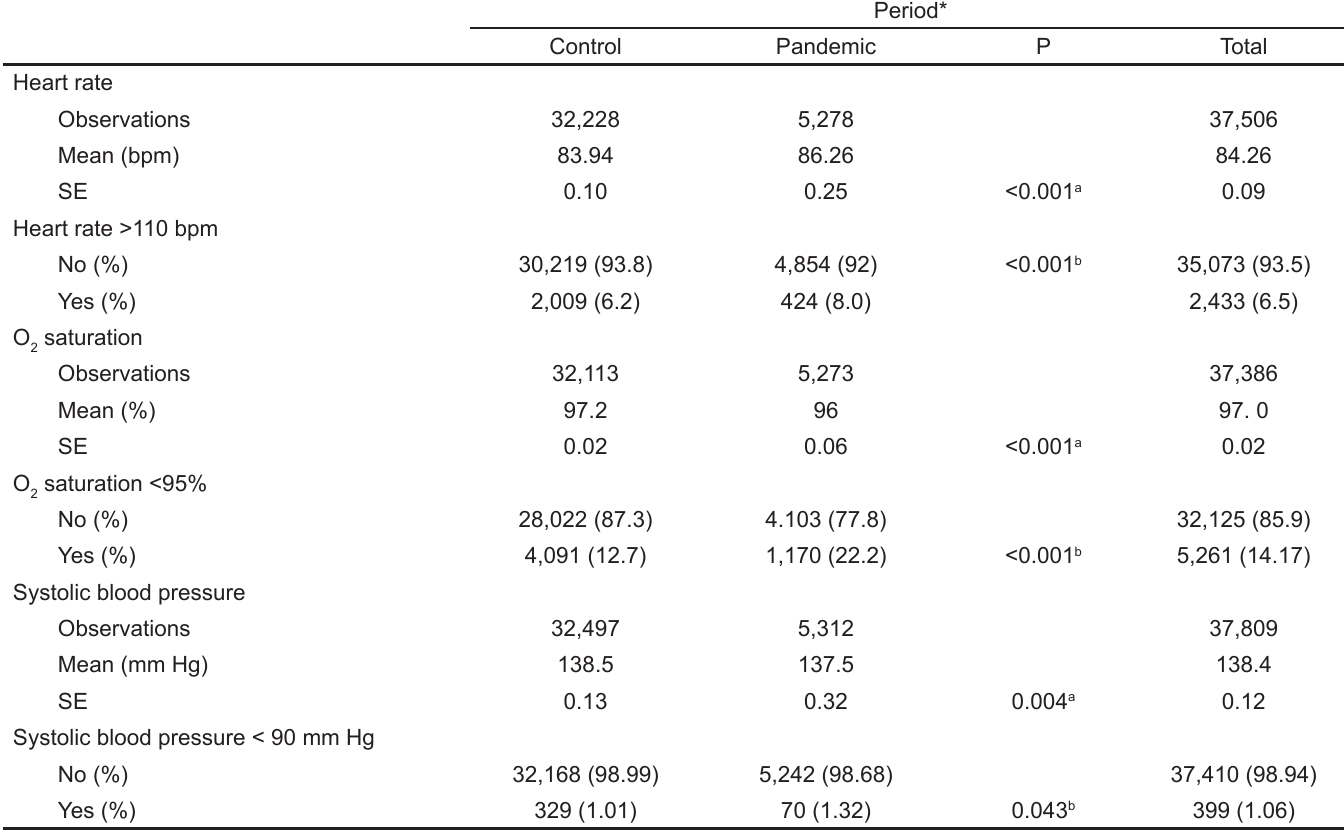
Table 2. Principal heart function parameters at presentation for patients included in the study, by period of